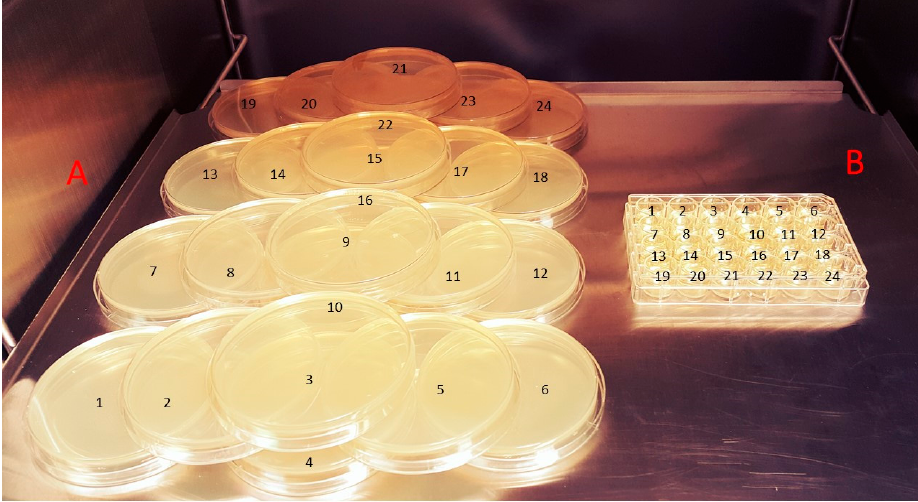
Figure 5. Comparison of place and resource consumption for the conventional Petri dish method of EOs testing ( A ) and the AntiBioVol ( B ) test. EOs testing ( A ) and the AntiBioVol ( B )